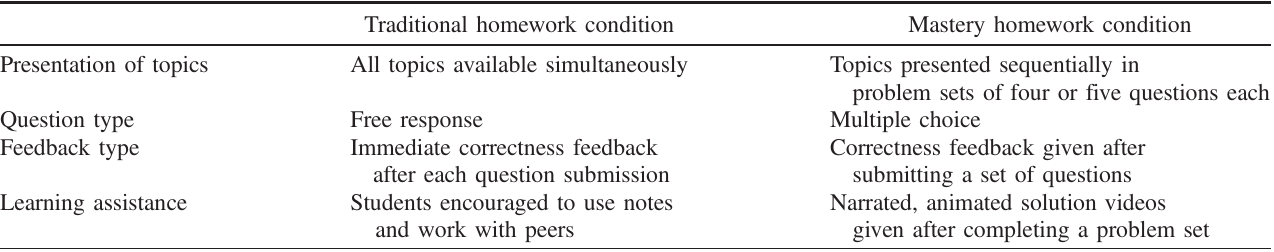
TABLE II. Summary of different homework